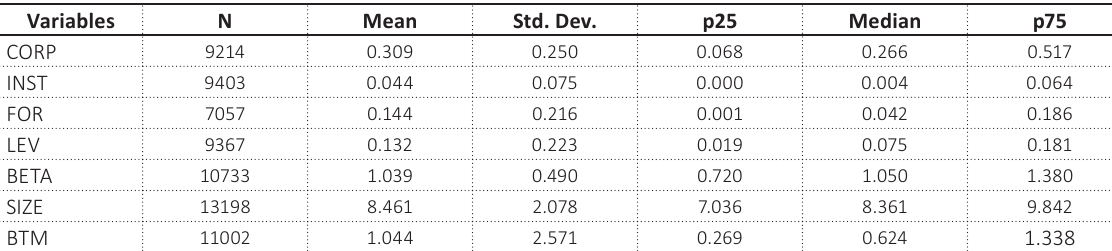
Table B2. Summary statistics of other variables